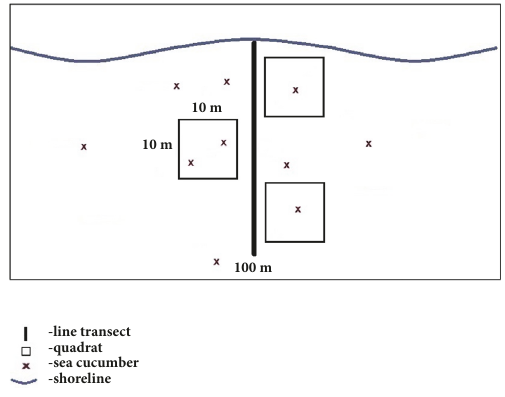
Figure 2: Illustration of sampling